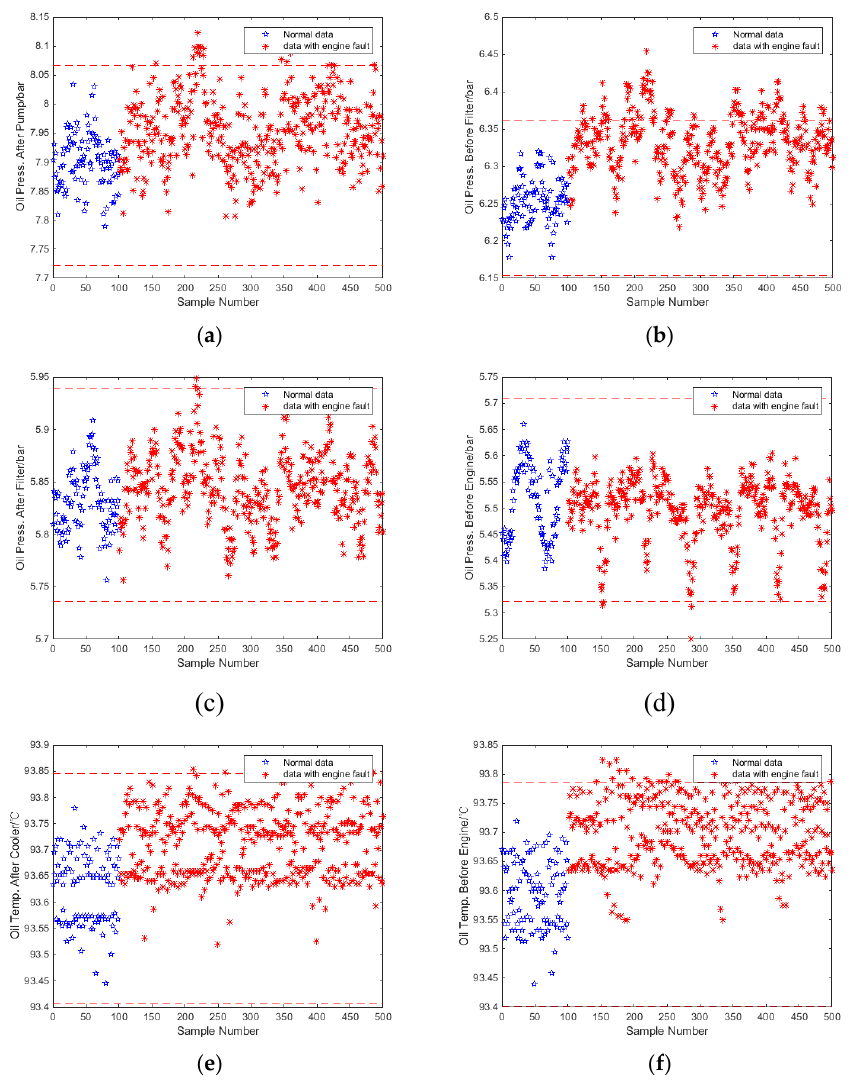
Figure 2. Monitoring charts of oil filter clogging by using the Pauta criterion (75% full load and 1800 rpm): ( a ) oil pressure after pump; ( b ) oil pressure before filter; ( c ) oil pressure after filter; ( d ) oil pressure before engine; ( e ) oil temperature after cooler; and ( f ) oil temperature before engine.